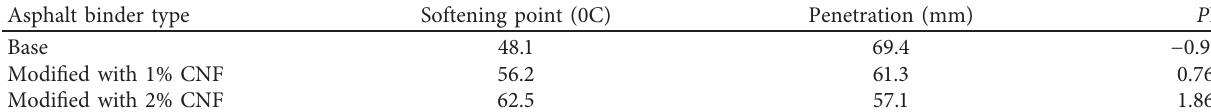
Table 3: Penetration and softening point amounts.